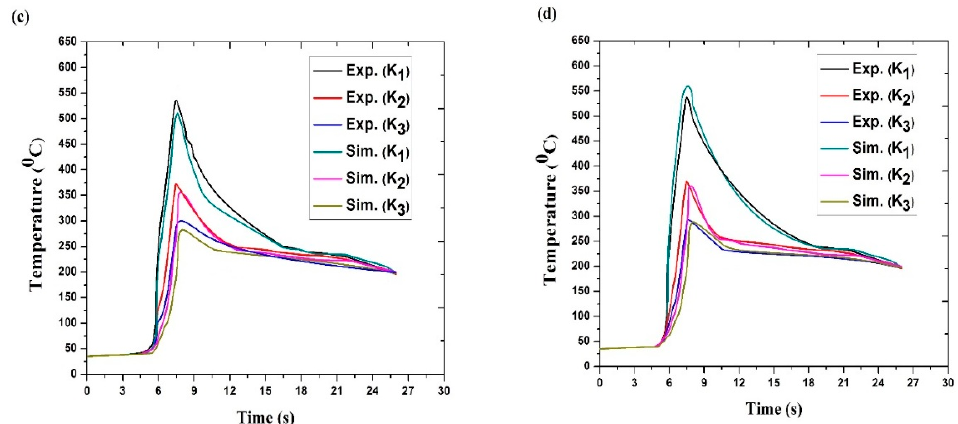
Figure 7. Experimental and numerical result for thermal histories at different parameters: ( a ) 192 W and 4 m/s; ( b ) 192 W and 6 m/s; ( c ) 202 W and 4 m/s; ( d ) 202 W and 6 m/s.